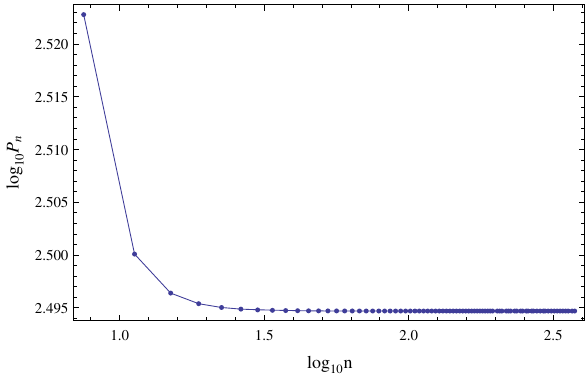
Fig. 1 The power spectrum obtained by numerically solving the per- turbations with ˜ m = 0, H 0 =